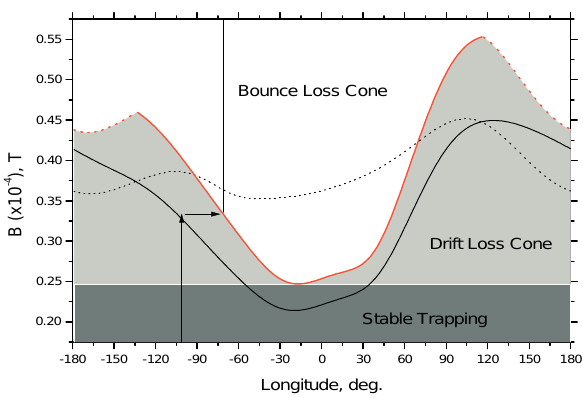
Longitude, deg. Fig. 6. Illustration of the 100-km atmospheric loss cones for L = 1.8. Electrons scattered into the drift loss cone are lost into the atmosphere in the Southern Hemisphere at longitudes between − 135 ◦ and − 20 ◦ (solid red curve), and in Northern Hemisphere between 120 ◦ and ∼ 180 ◦ (dotted red curve). Approximate satellite locations at 500km in the south (north) are indicated solid (dot- ted) black curve. The schematic drawing shows that drift loss cone precipitation in the Northern Hemisphere requires a major change in magnetic field strength (i.e. in pitch angle) to transport electrons from stably trapped orbits. Vertical arrow at the longitude of − 100 ◦ , the location of the conjugate flashes for the event on 12 November schematically represents scattering from the stable trapping to the drift loss cone. The direction of the electron drift is marked by a horizontal arrow, and a vertical line at − 70 ◦ indicates the longitude of the observed hard X-ray enhancements.